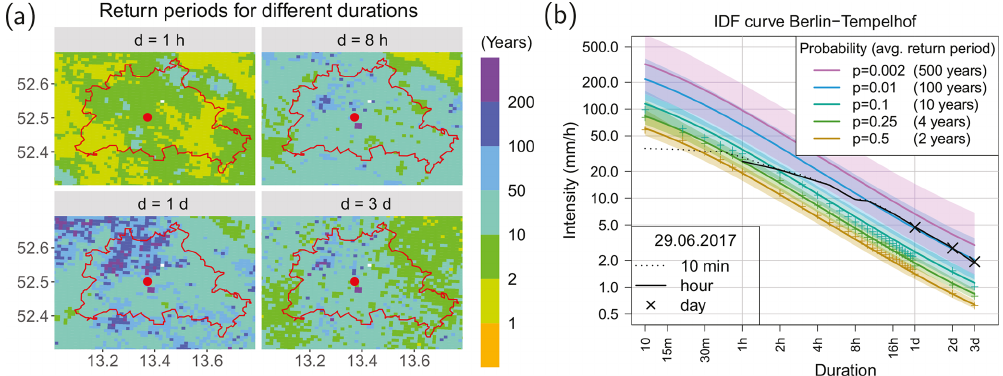
Figure 11. (a) Return periods of this event’s intensity from gridded RADKLIM (1km × 1km) data using a duration-dependent GEV distri- bution. Red dot: position of DWD weather station Tempelhof used to construct the IDF curve in (b) . (b) IDF curves from station-based data. The coloured lines show return periods from the d -GEV model, the black line indicates intensity of the event on the 29 June for different temporal measurement resolutions. Empirical quantiles are denoted as coloured “ + ”. The 95% confidence intervals come from 1000-fold